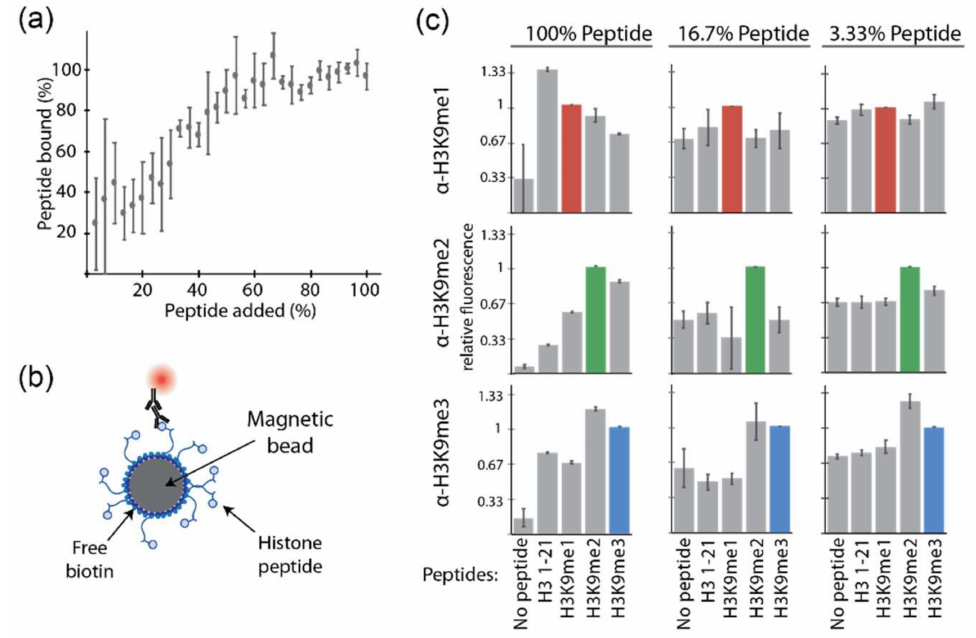
Figure 4. Decreasing peptide density on beads does not rescue antibody labeling specificity. ( a ) Range of the H3K9me2 peptide coverage on magnetic beads was achieved by changing the free biotin to biotinylated peptide ratio. Peptide bound percentage was measured via flow cytometry; error bars represent the standard deviation from triplicate samples. ( b ) Interaction between low-peptide-density magnetic beads and the corresponding primary and secondary antibodies. ( c ) Relative fluorescence of each peptide–antibody pairing. The pairings with expected specific interactions with each antibody are indicated by colored bars. The buffer used was 1% PBSAT; error bars represent the standard deviation from triplicate